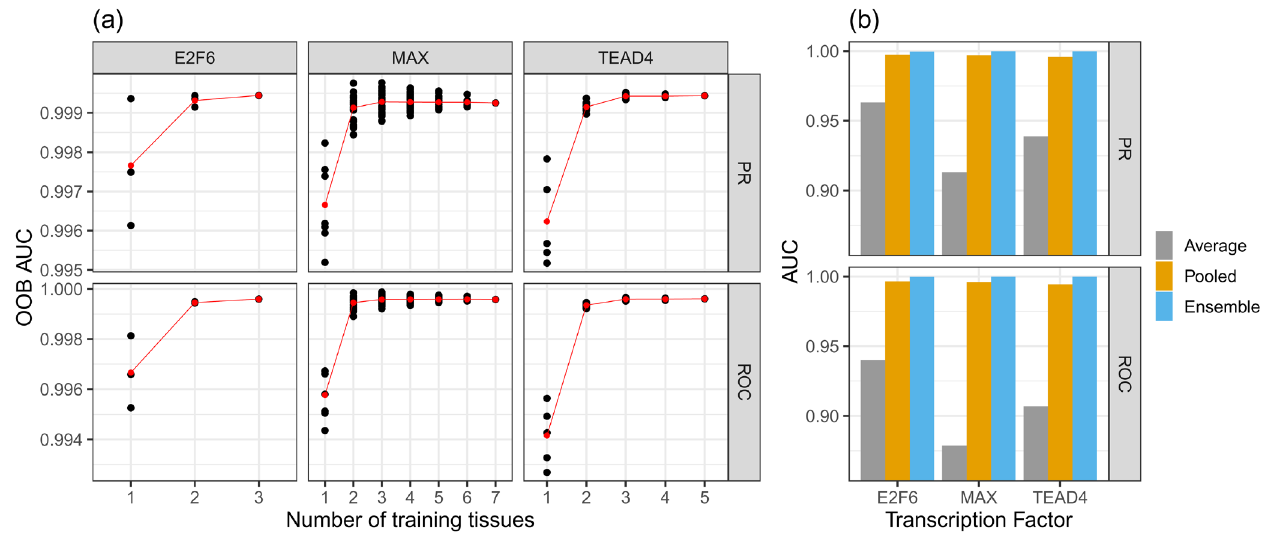
Figure 4. Comparison of tissue number and classifier setups for the three TFs E2F6, MAX, and TEAD4. a ) Model performance as a function of number of tissues used for training. The OOB reduces if more tissues are included in the ensemble learning. Red dots represent the mean classification error across all tissue-specific classifiers. The black points represent individual models. b ) Comparison between two ensemble models: averaging (takes the average of all individual RF predictions) and the RF ensemble model. In addition, one RF classifier was trained on pooled data sets comprised of training data for all available tissues for one target TF. The ensemble models perform better than the models based on aggregated